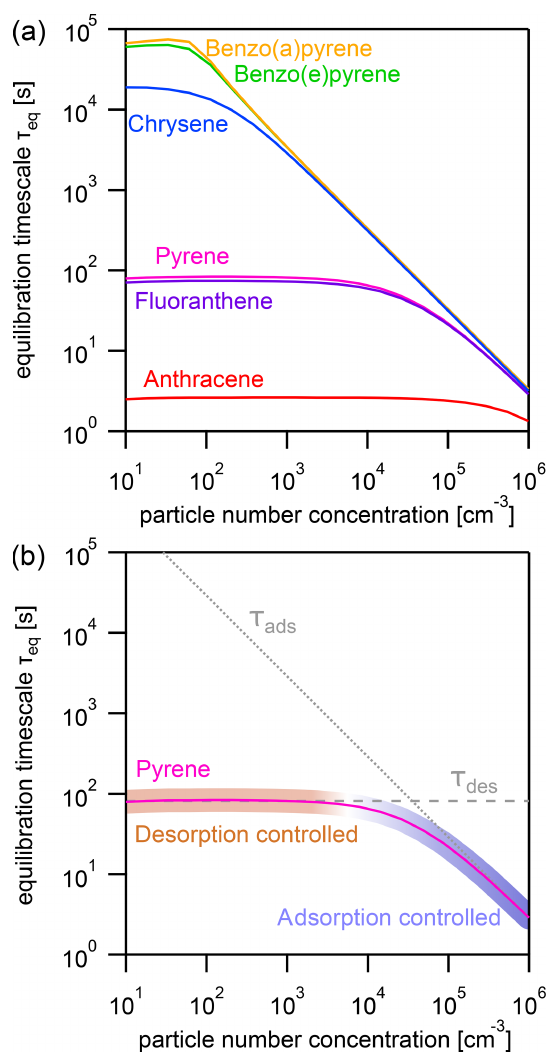
Figure 3. (a) Equilibration timescale τ eq for different PAHs as a function of particle number concentration at a constant tempera- ture ( T = 298K). (b) Comparison of the equilibration timescale of pyrene to the timescales of adsorption τ ads and desorption τ des , highlighting the transition between adsorption-controlled and desorption-controlled